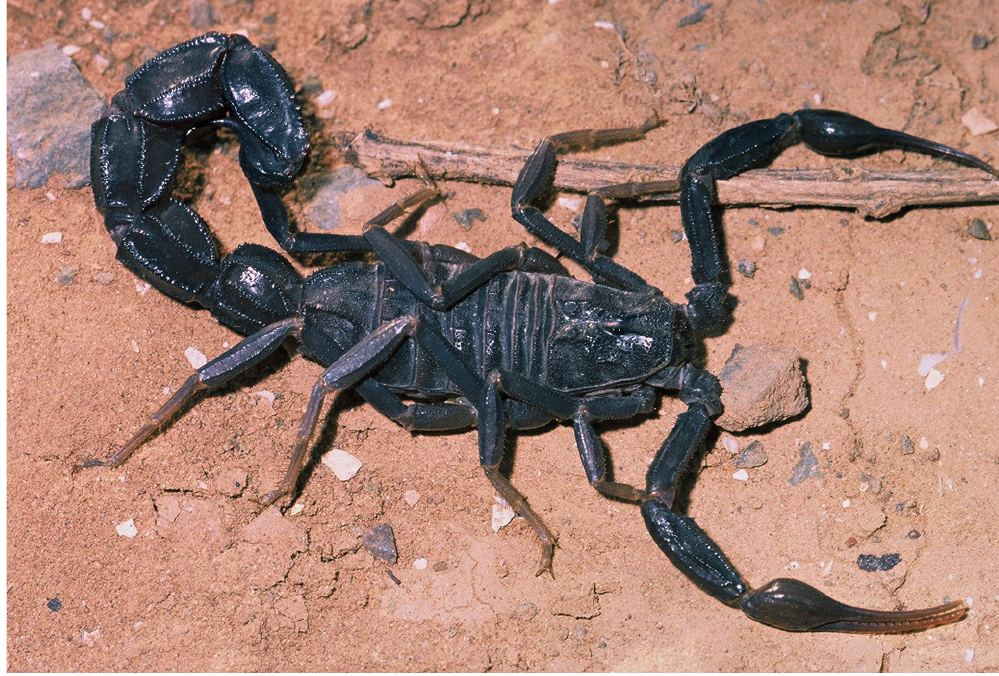
Figure 3. Androctonus liouvillei (Pallary), male from Maroc. A Buthidae scorpion with slender pedipalps and strong metasoma (copyright by M. Aymerich, reproduced with permission). Scorpions are major predators but can also represent a selected prey for other predators [6,7]. Consequently, the evolution of predation and defensive strategies certainly represented a major aspect in the successful duration of their lineage [1,3]. Predation and defensive strategies depend mainly on three components: ● Morphology of the chelae and structure of the chelae finger